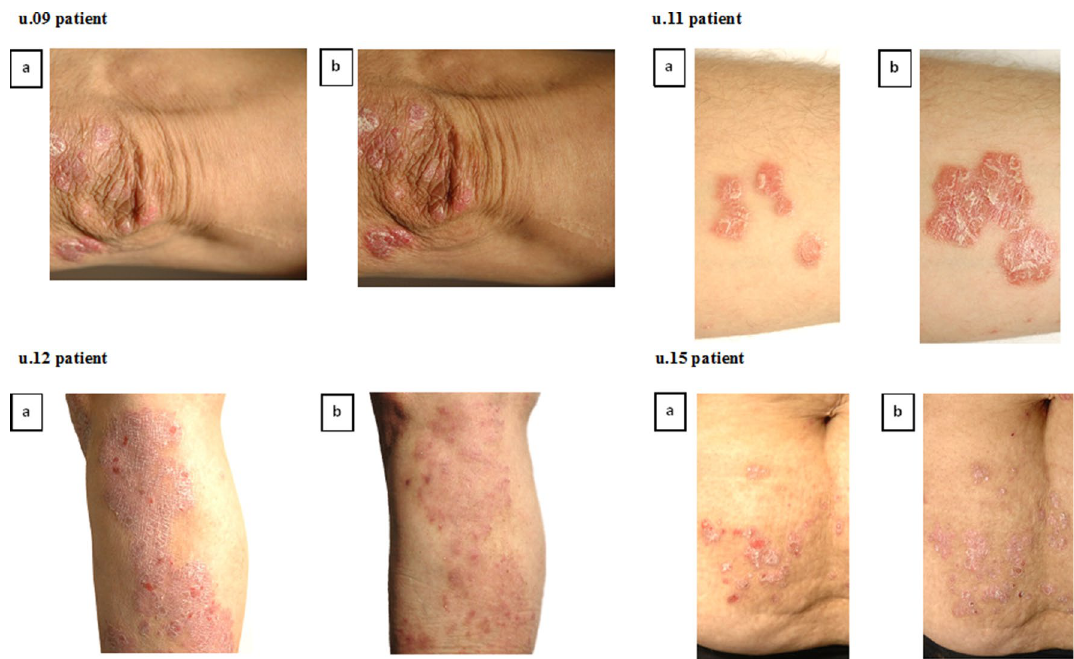
Figure 2. Individual genistein score over time. Specific genistein responses in four patients, named u.09, 11, 12 and 15, by baseline ( a ) and after 56 days of genistein or placebo treatment ( b ).